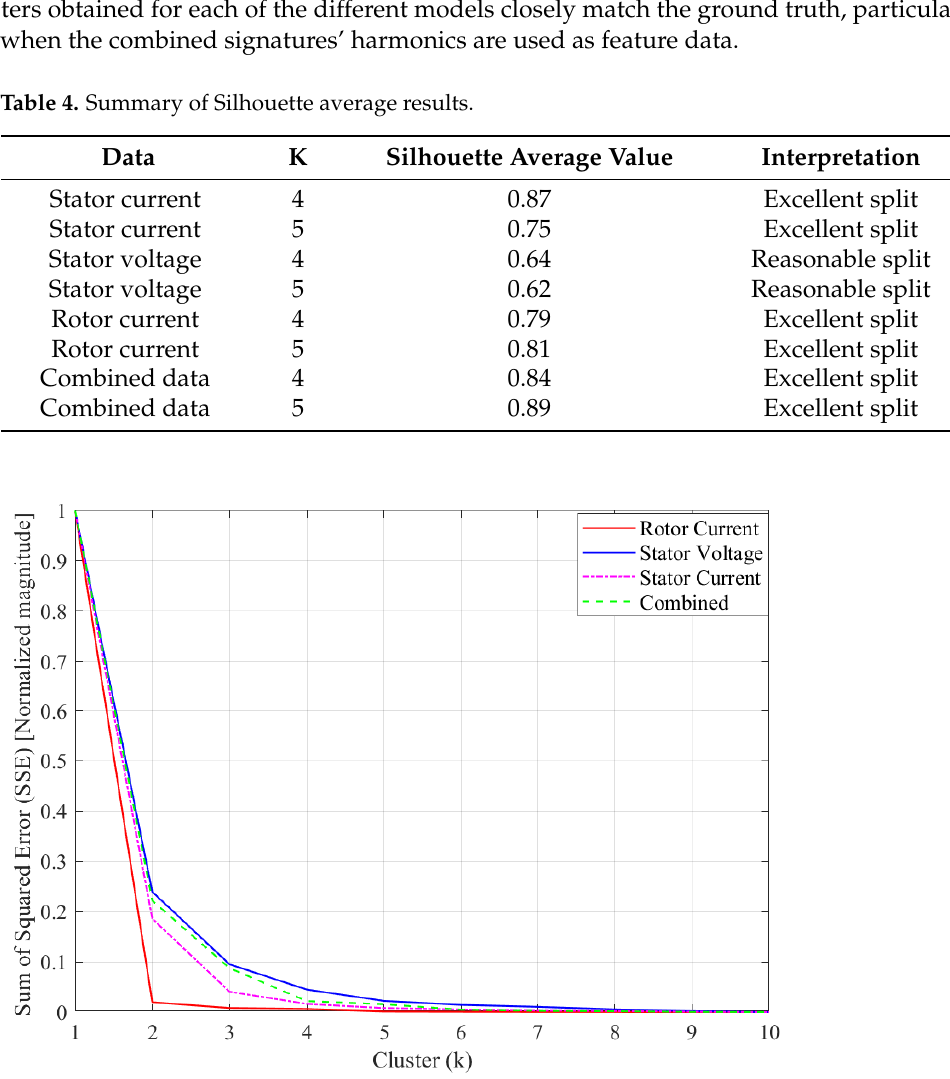
Figure 19. Elbow plots of clustering results for different feature sets—i.e., stator current, rotor current, stator voltage and combination of